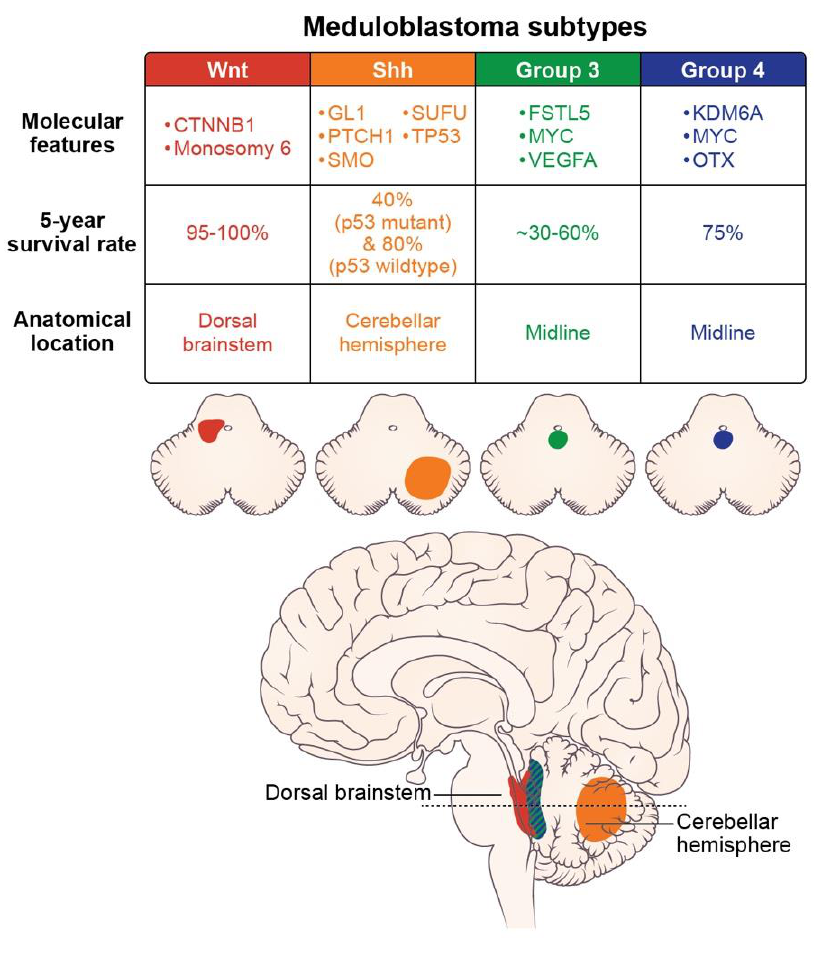
Figure 2. Molecular features (somatic mutations and amplifications), prognosis, and location of the medulloblastoma subtypes (axial images adapted from Juraschka, et al., 2019).